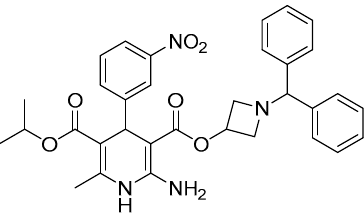
Figure 2. Structure of azelnidipine.